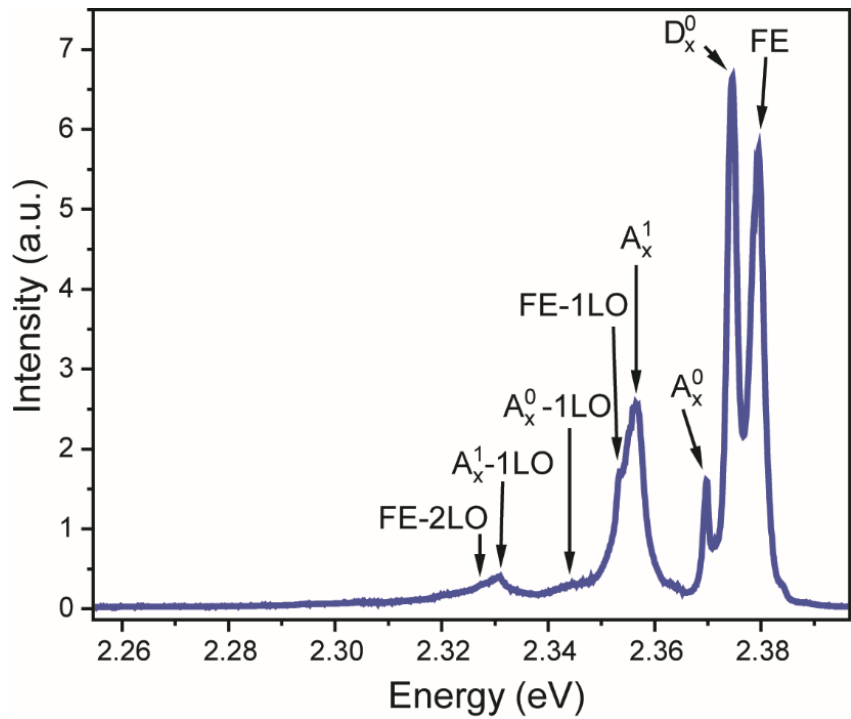
Figure 3. Emission spectrum of ZnTe film under 514 nm excitation at T = 20 K. Table 1. Assignment of ZnTe exciton luminescence bands, T = 20 K [42 – 47].